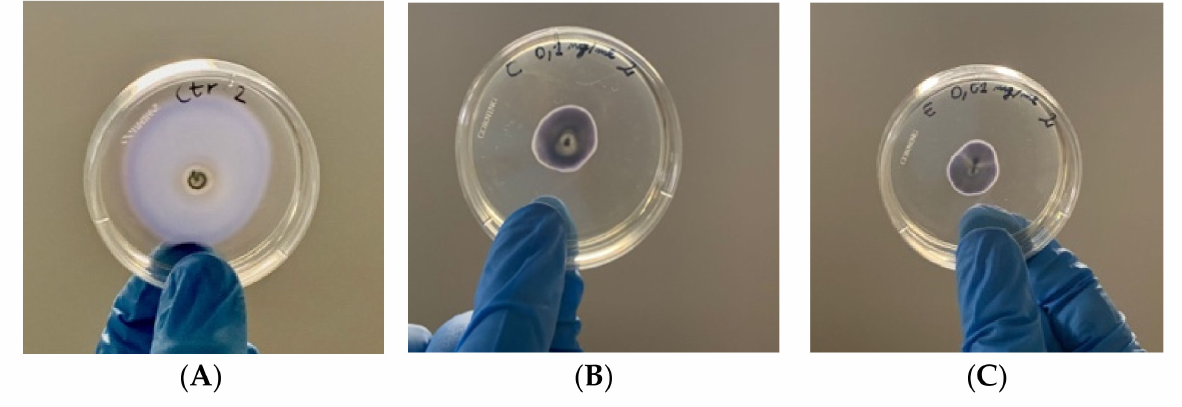
Figure 3. Effects of MOEs on swarming motility; images represent soft-agar plates inoculated with EA; the colored area is formed by formazan metabolized by the swarmed bacteria. ( A ) Control; ( B ) MeOH-MOE 0.1 mg/mL; ( C ) HAMD-MOE 0.01